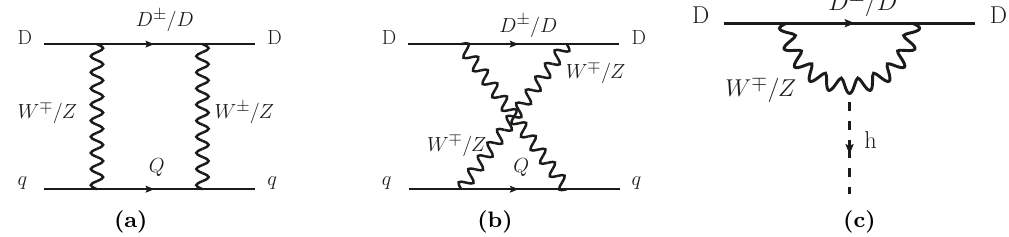
Figure 5. One-loop diagrams contributing to DM direct detection. If the external quark q is a heavy flavour, it can be connected to the gluons in the nucleons by closing a second